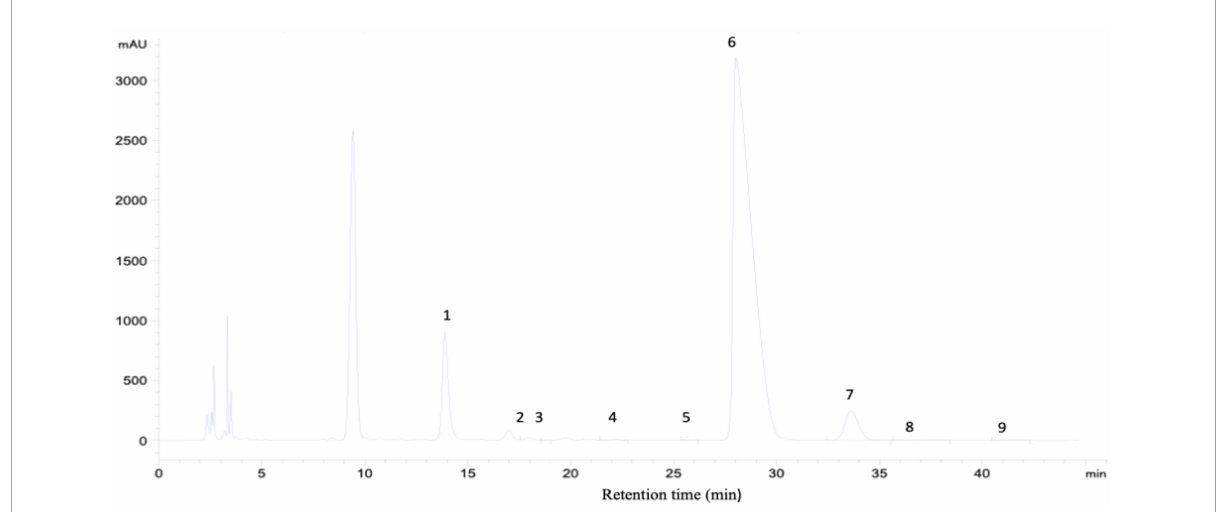
FIGURE2 Characterization of MEP and monosaccharide composition analysis by HPLC, chromatogram of standard monosaccharide, 1-mannose, 2-ribose, 3-rhamnose, 4-glucuronic acid, 5-galacturonic acid, 6-glucose, 7-galactose, 8-arabinose, and 9-fucose.